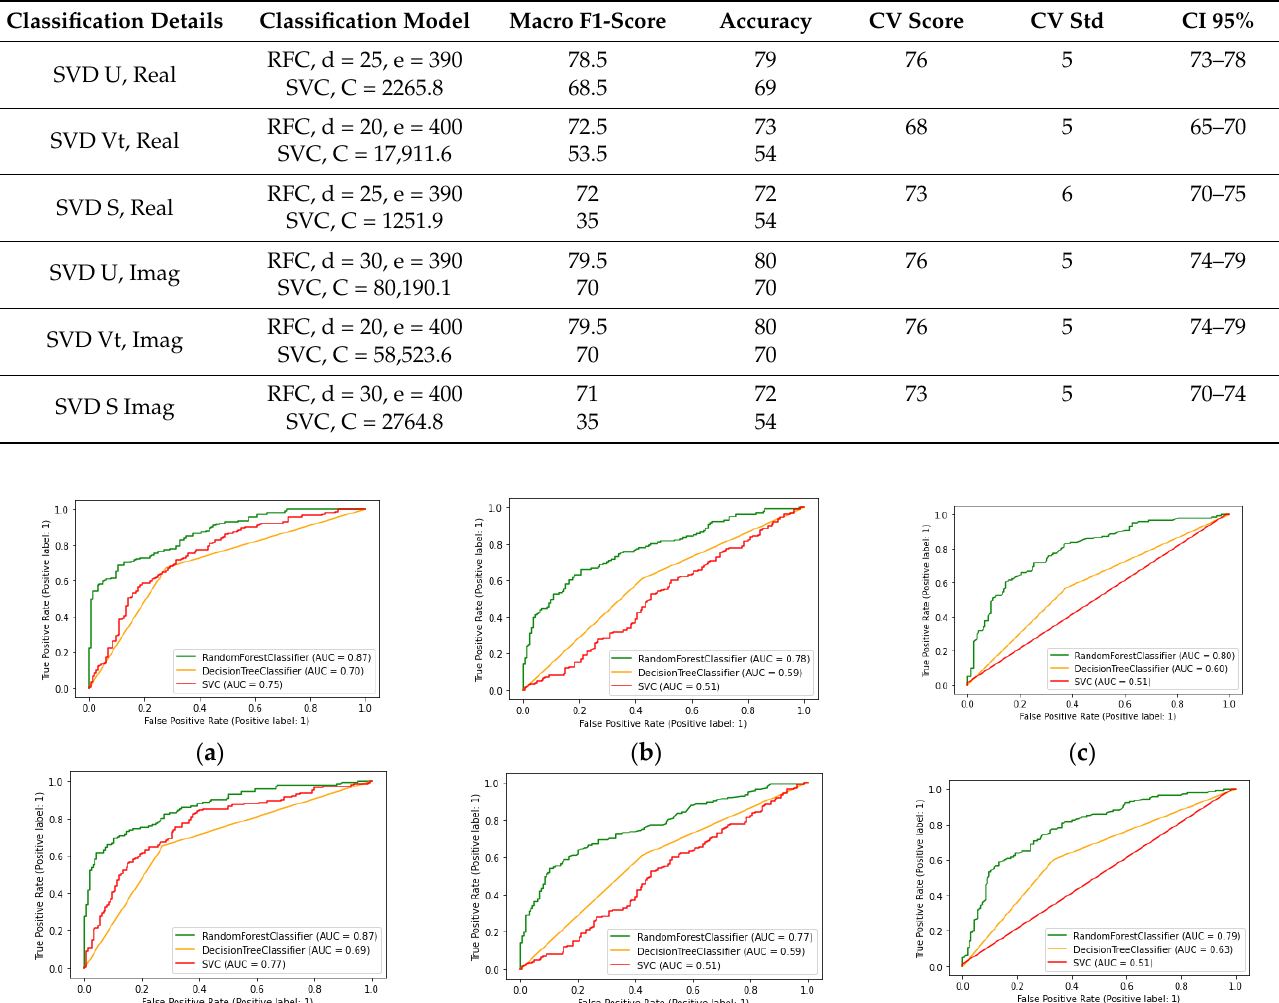
Table 4. Healthy vs. COPD classification of parameter tuning results. In these, d stands for depth, and e stands for the number of estimators.